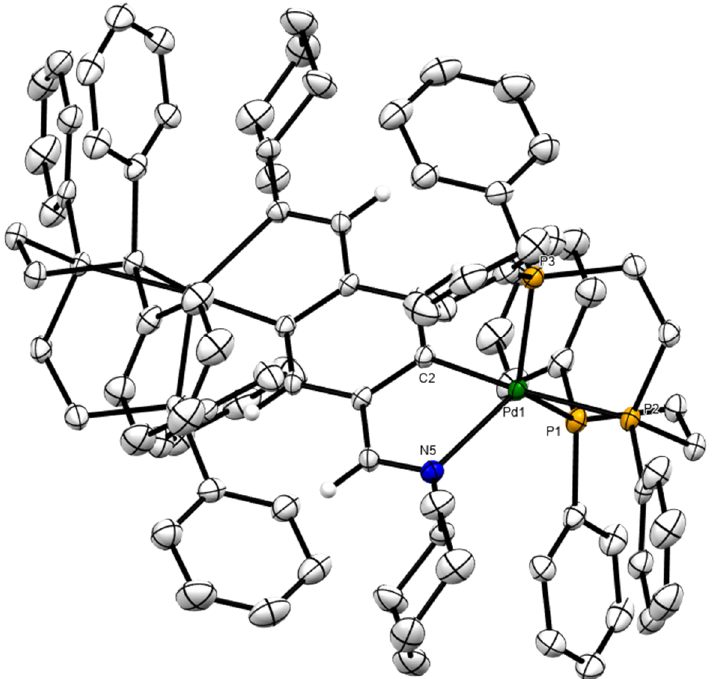
Figure 2. ORTEP drawing of complex 10 (from 2a ) with thermal ellipsoid plot shown at 50% probability level. Hydrogen atoms for the metalated phenyl ring and C=N groups are shown; the remaining hydrogen atoms and PF 6 counterions have been omitted for clarity. Selected bond distances (Å) and angles (°) for 10 : Pd(1)-C(2) 2.046(2), Pd(1)-N(5) 2.2869(19), Pd(1)-P(1) 2.3127(6), Pd(1)-P(2) 2.3416(6), Pd(1)-P(3) 2.3147(6), P(2)-Pd(1)-P(1) 85.06(2) P(2)-Pd(1)-P(3) 84.22(2) P(1)-Pd(1)-P(3)